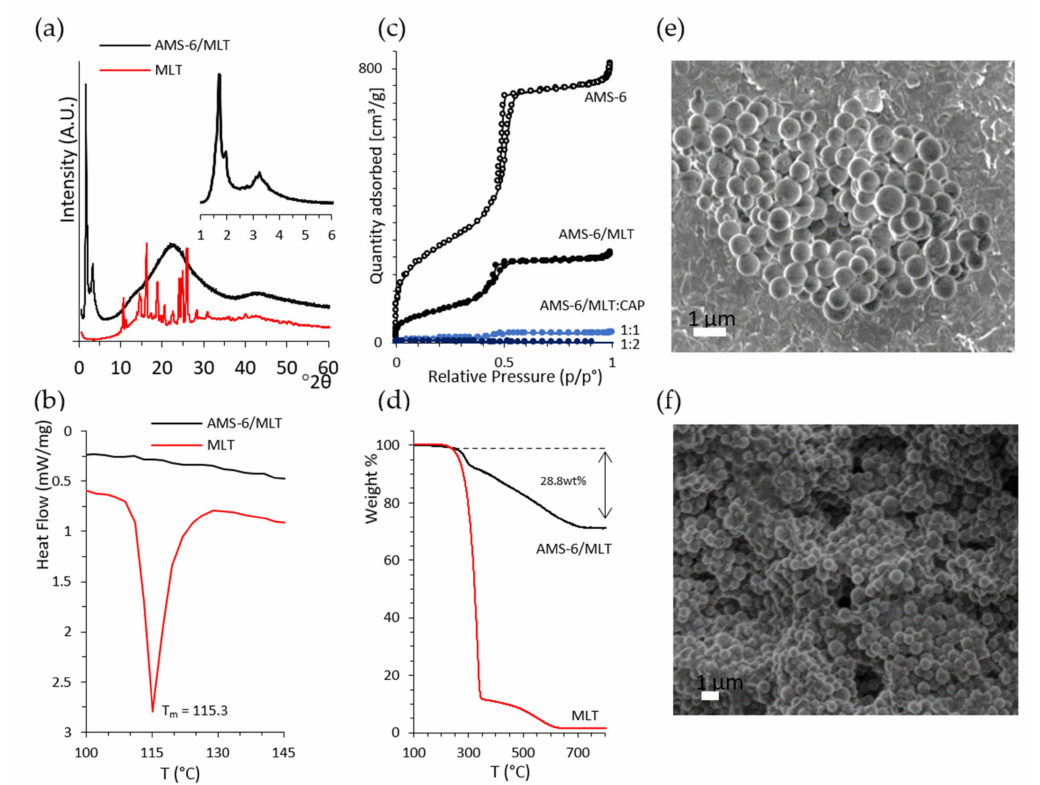
Figure 2. ( a ) X-ray diffractogram of the pure melatonin (MLT) and melatonin loaded within mesoporous silica (AMS- 6/MLT), showing the absence of diffraction peaks for crystalline mLT after loading. The inset shows the low-angle mesoscale peaks typical of the cubic structure of AMS-6 [30]. The cubic unit cell was calculated to be 126.6 Å. ( b ) The DSC trace of mLT shows a melting endotherm peak at 115.3 ◦ C, which is absent in the trace of AMS-6/MLT. ( c ) Nitrogen sorption isotherm curves from AMS-6, AMS-6/MLT and AMS-6/MLT:CAP-coated samples showing the decrease in porosity parameters as a function of mLT loading and CAP coating. ( d ) Thermogravimetric analysis confirming a loading of 28.8 wt% of mLT within the pores. Representative SEM images recorded on ( e ) AMS-6 and ( f ) AMS-6/MLT:CAP(1:1).